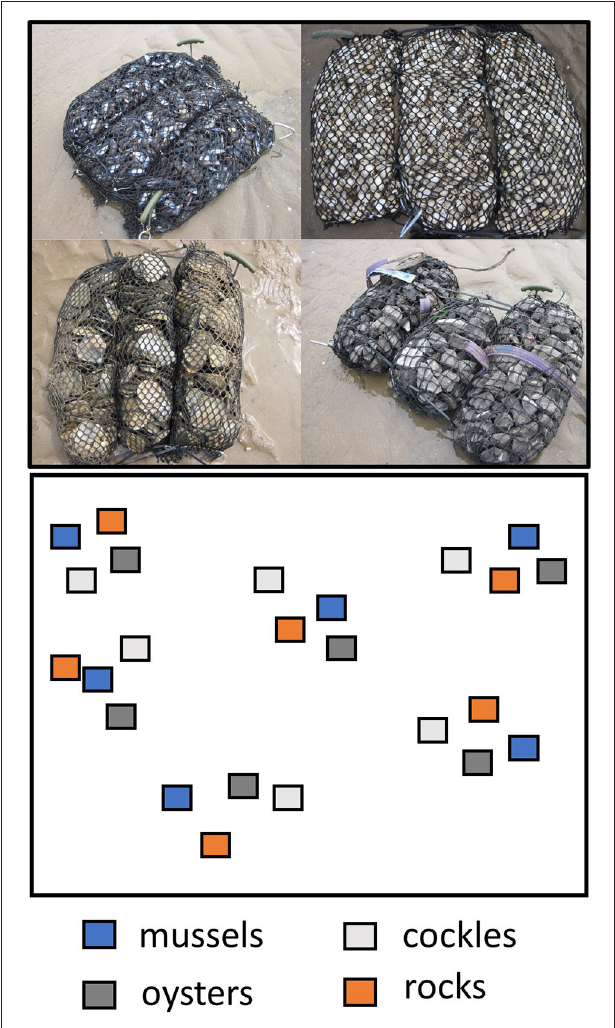
FIGURE 1 | Schematic design of the field experiment with different types of reef-units arranged in blocks, and images of the experimental reefs made of oyster, cockle and mussel shells and limestone rocks.